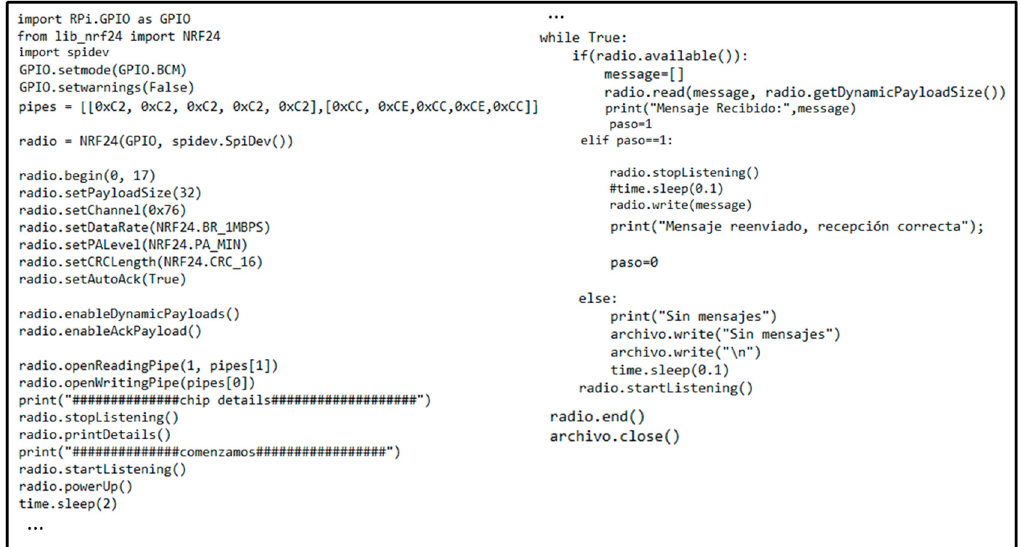
Figure A6. Pi programming for nRF24L01+ device .